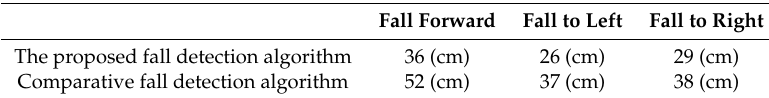
Figure 19. Wearable sensor-based user fall detection experiment using the walking-aid robot (falling down). ( a ) Feature d1(n) is the distance between the center of pressure (COP) and the midpoint of the user’s two feet. Feature d2(n) is the height of the user’s waist. µ ( d ( n )) is the membership degree value. The threshold value is 0.2. ( b ) The moving velocities of the robot. Table 5. The average relative distance when falling is